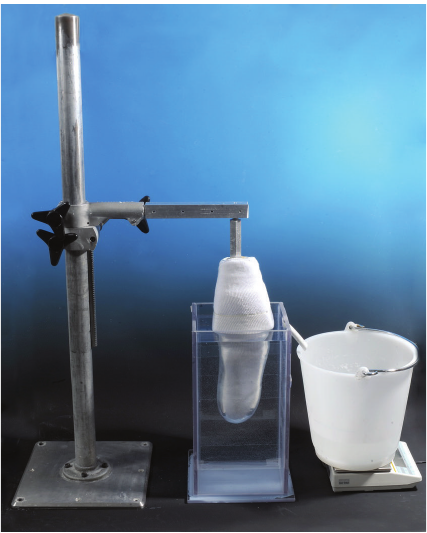
Figure 1: Water weighting of residual limb covered with one layer of Terry Cloth